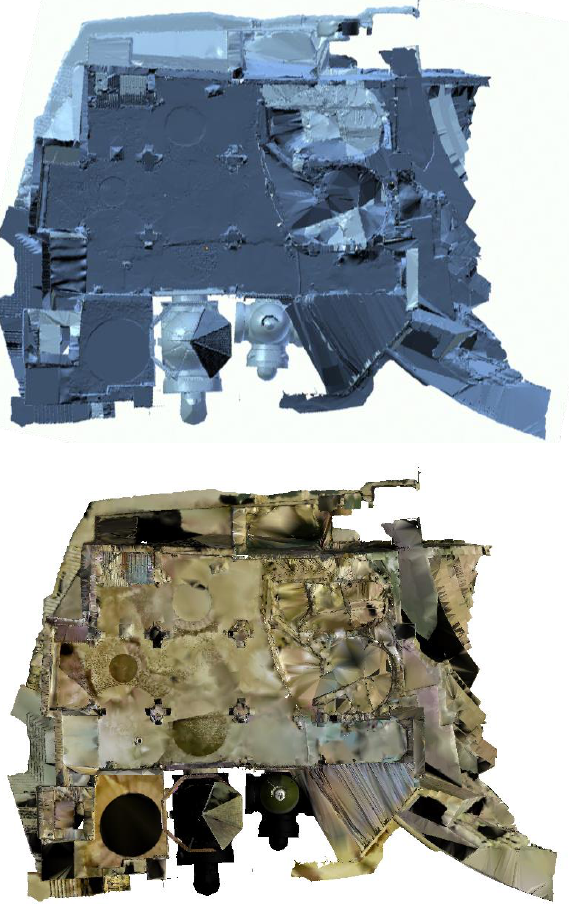
Figure 9. Building plan with the mesh of points without texturing (above) and with the mesh of textured